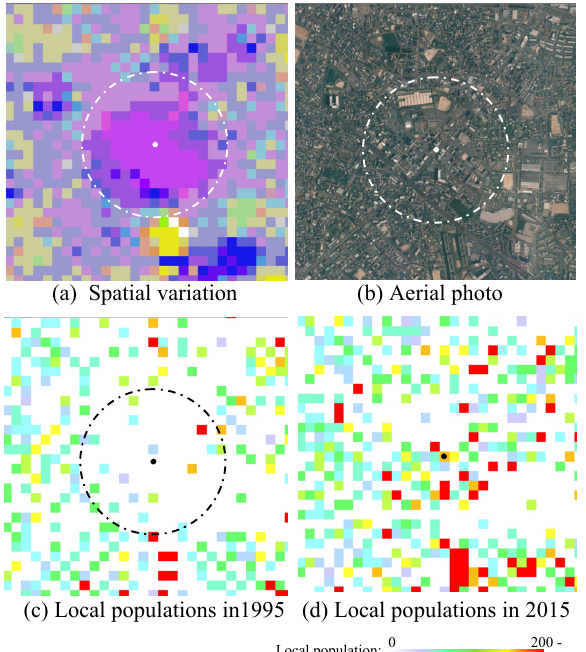
Figure 14 . Partial image of site F in Figure 10 along with aerial photograph and local population distributions. Dashed circle denotes ASP = 210 m in 1995, while dotted circle means ASP = 570 m in